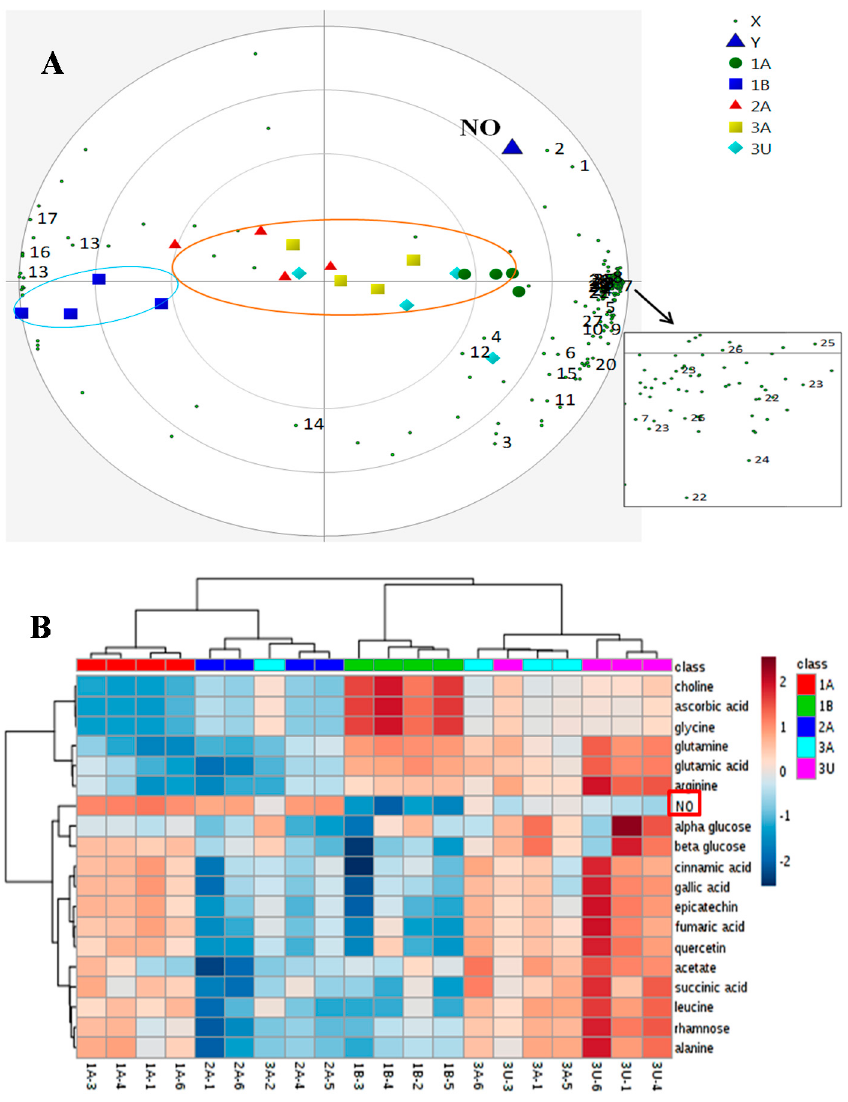
Figure 6. ( A ) PLS biplot where; 1, beta glucose; 2, alpha glucose; 5, acetate; 6, arginine; 9, proline; 10, alanine; 12, glutamine; 13, fructose; 14, choline; 16, ascorbic acid; 17, glycine; 19, maleic acid; 20, succinic acid; 21, fumaric acid; 22, kaempferol; 23, quercetin; 24, gallic acid; 25, epicatechin; 26, cinnamic acid; 27, rhamnose in flavonoid; 28, leucine; ( B , C ) the heatmap visualization of metabolite variation and NO inhibition of different Ajwa dates; 1A (Grade 1 from al-Aliah); 1B (Grade 1 from Bir